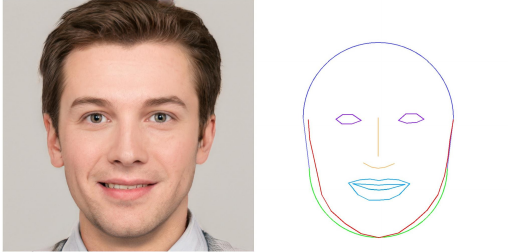
Figure 10. Example image and face contour.